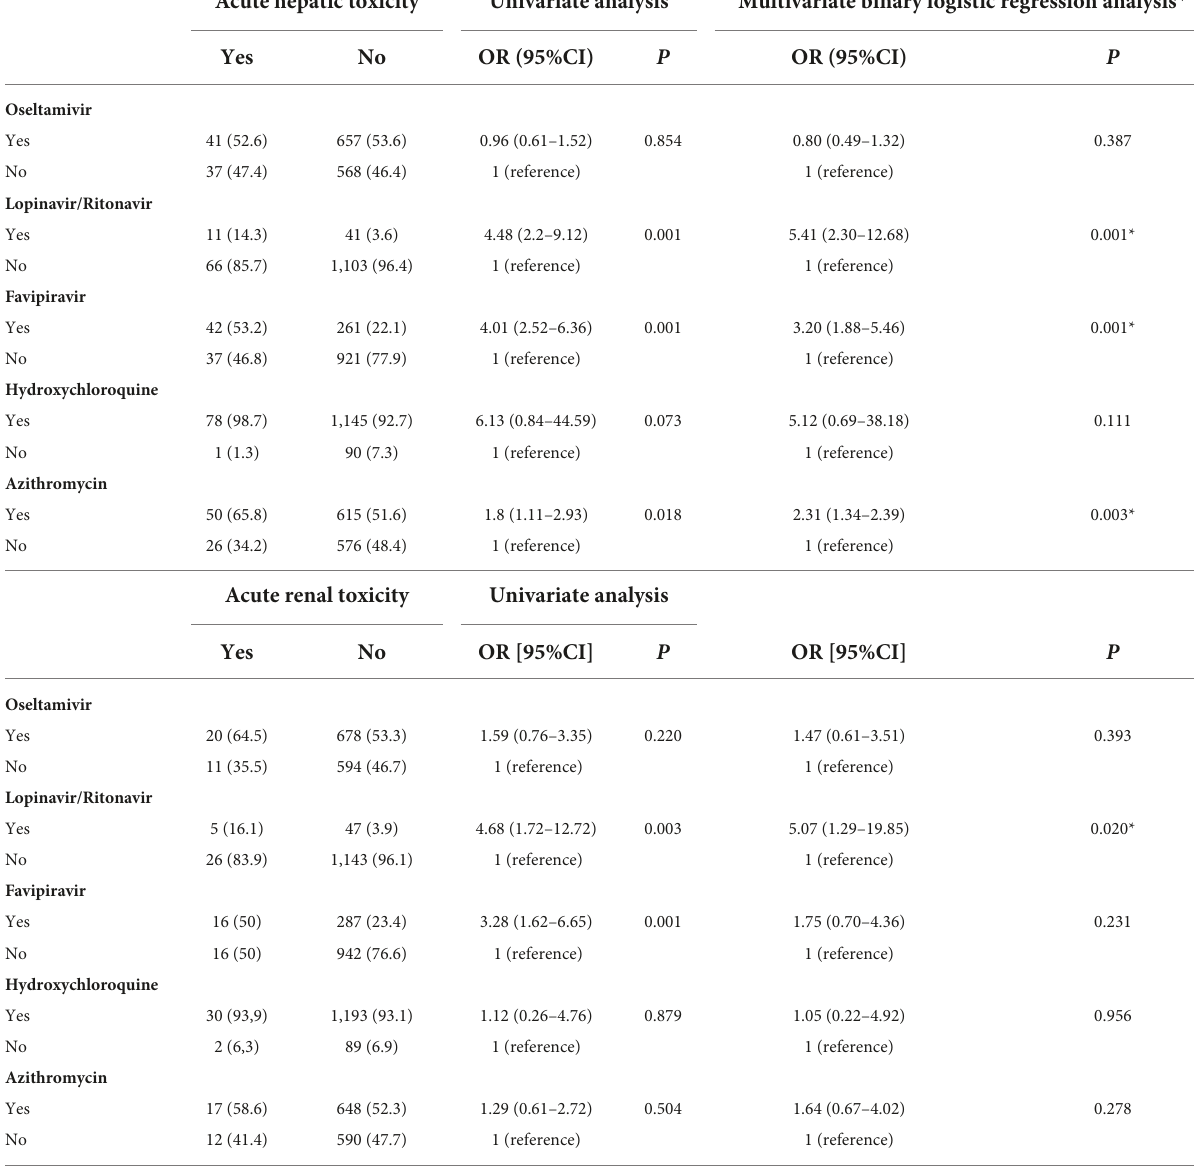
TABLE 6 Acute hepatic toxicity and acute renal toxicity during treatment with drugs. Acute hepatic toxicity Univariate analysis Multivariate binary logistic regression